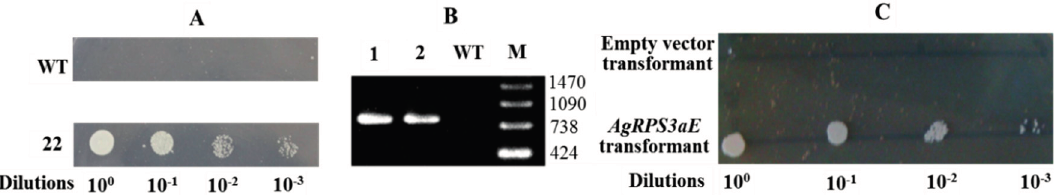
Figure 1. Cloning of the AgRPS3aE gene and verification of salt tolerance. ( A ) A salt-tolerant transformant was screened from a yeast cDNA expression library on solid SD minimal medium ( − uracil, +galactose) containing 20% ( w / v ) NaCl for 3–5 days at 30 °C; ( B ) The AgRPS3aE gene was amplified using a salt-tolerant colony as a template. Lane 1, Lane 2: AgRPS3aE gene; Lane M: Marker; and ( C ) The salt-tolerance properties conferred by the AgRPS3aE gene were verified by the heterologous expression of AgRPS3aE in yeast strain AH109. The empty vector transformant could not survive in a high-salt environment. The transformants were cultivated under 20% NaCl for 3–5 days at 30